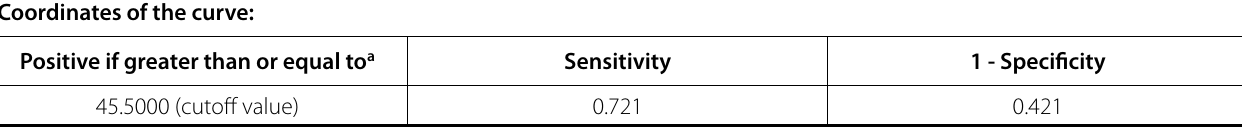
Table 4 . Coordinates of the curve for preoperative LAD values – sinus rhythm in the first month. Coordinates of the curve: